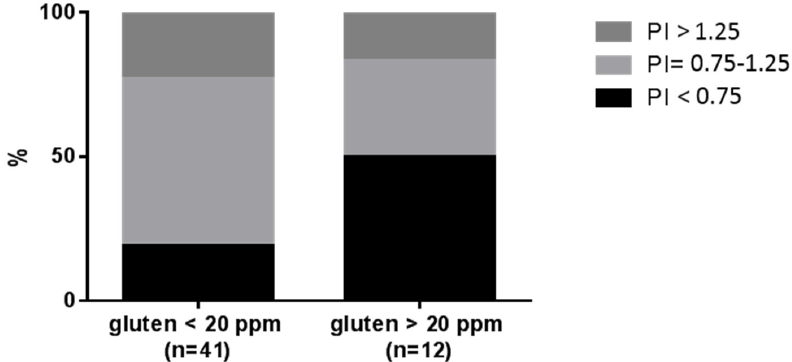
Figure 4. Distribution of price indexes (PIs) according to the level of gluten contamination.